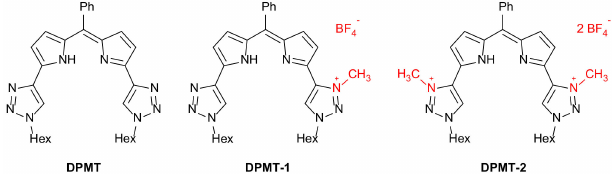
Figure 2. Structures of the targeted bis-triazole dipyrromethene ligands